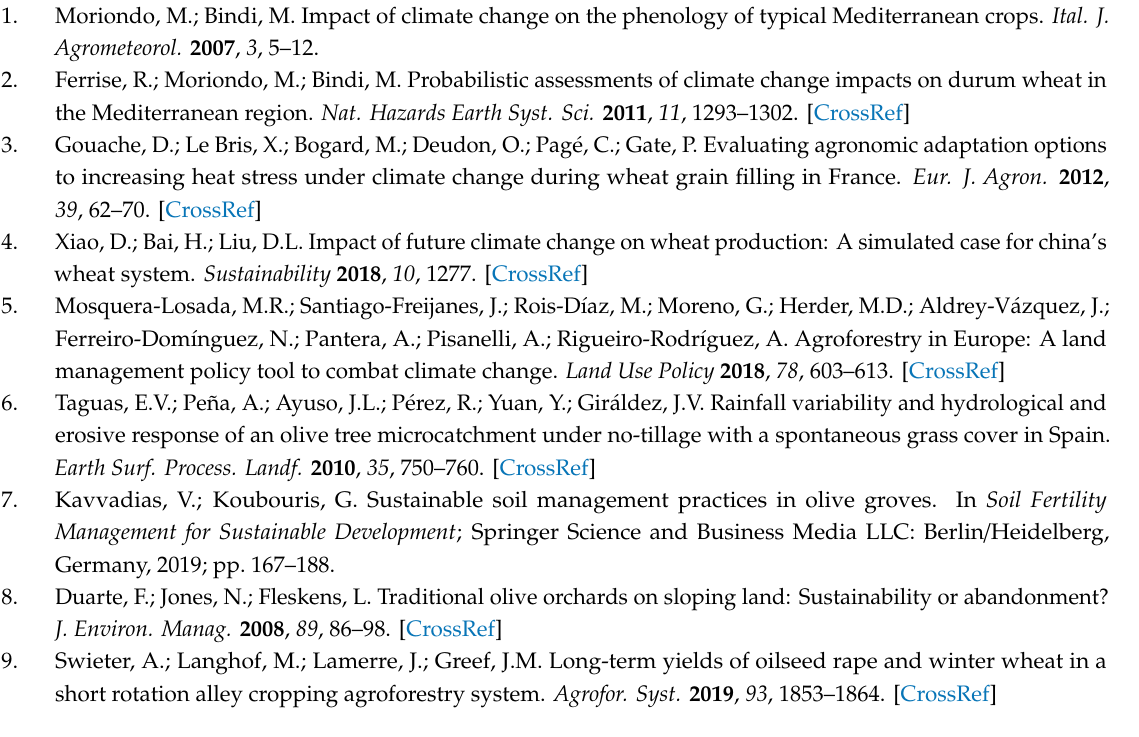
Figure S1: Dynamics of the yearly mean maximum and minimum temperatures (T) and linear regression trends at the INRA Station (Mauguio—Montpellier) from 1997 to 2017; Figure S2: Sketch of the olive tree / durum wheat intercropping in the AF (left) and AF + (right)